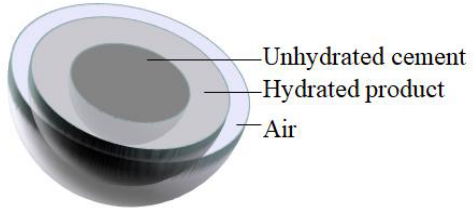
Figure 2. Hydration state of single cement particles.